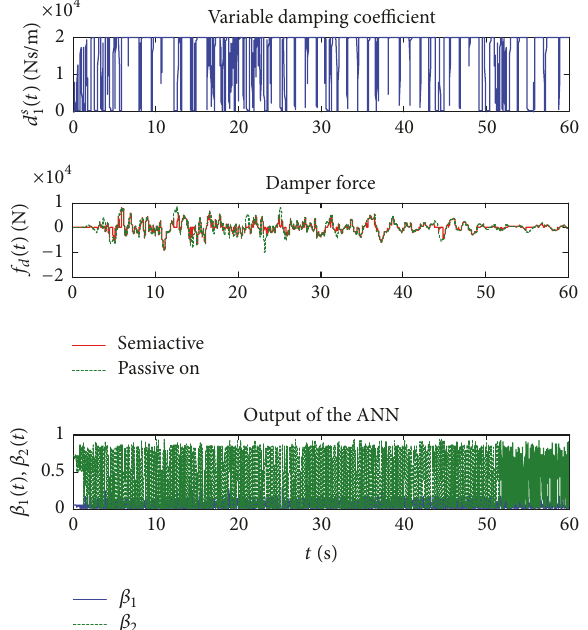
Figure 12: Simulation results for the BCJL1 earthquake disturbance; variable damping coefficient 𝑑 𝑠 1 (𝑡) , force of damper 𝑓 𝑑 (𝑡) , and output signals of the ANN 𝛽 1 (𝑡) and 𝛽 2 (𝑡) .